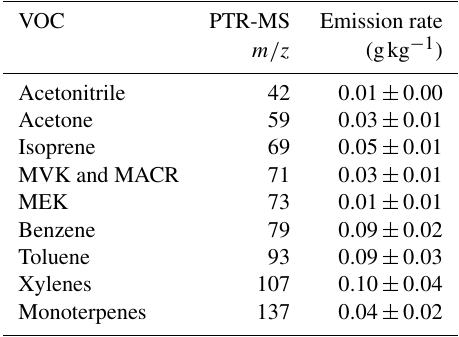
Table 3. Emission factors (gkg − 1 of meat cooked) for several